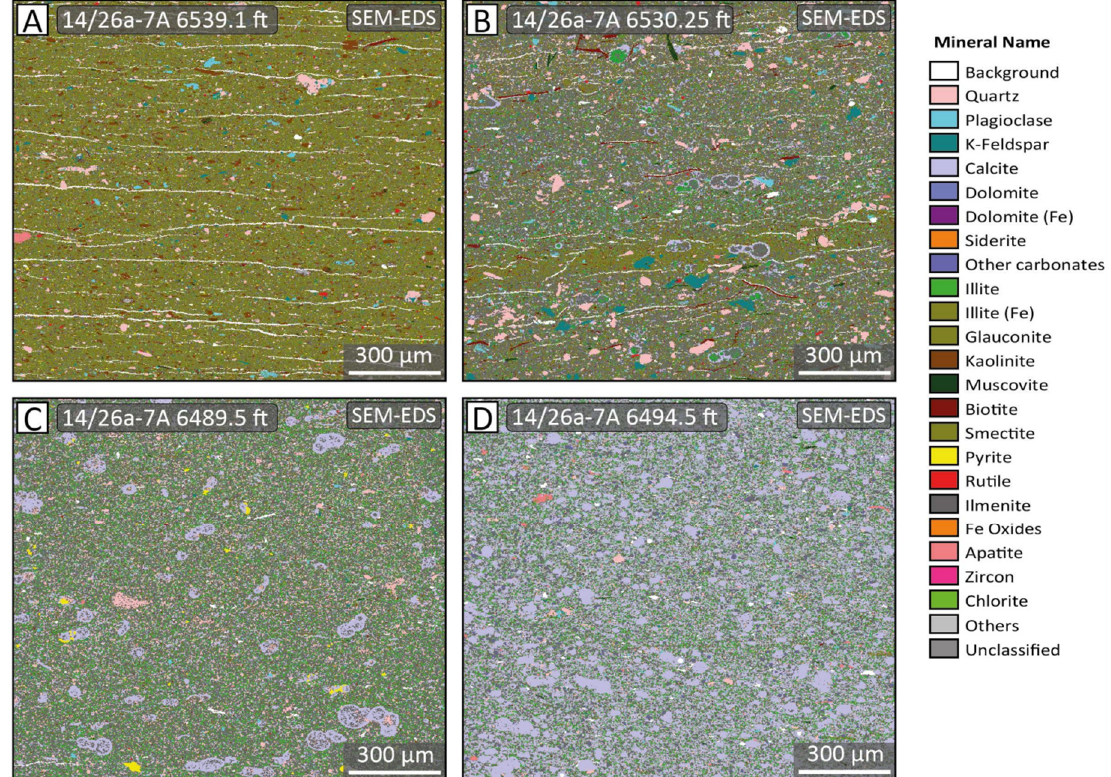
Figure 10. High-resolution SEM-EDS images of the Rodby Shale from well 14 / 26a-7A presented in order of increasing calcite concentration. These images reveal the mineralogy of samples but the pores in these shales are beyond the resolution of the SEM-EDS device (approximately 1 to 2 µ m minimum resolution). The key to relate the selected colours to mineral type is also shown. ( A ) Core depth 6539.1 ft: smectite (77%), kaolinite (11%) and minor silt-grade quartz dominate this calcite-free sample. The cracks are artefacts of sample preparation but reveal the dominant shale parting orientation ( B ). Core depth 6530.25 ft: smectite (57%), quartz, (12%) and calcite (11%) dominate this sample but it also contains a significant quantity of detrital biotite (12%). Calcite is partly present in the form of microfossils ( C ). Core depth 6489.5 ft: smectite (50%), quartz, (22%) and calcite (22%) dominate this sample. Calcite is present in the form of relatively abundant microfossils. ( D ). Core depth 6494.5 ft: calcite-dominated sample (59%), with some smectite (18%) and other minerals. Calcite is present in some microfossils, but the majority is disseminated and recrystallised cement.